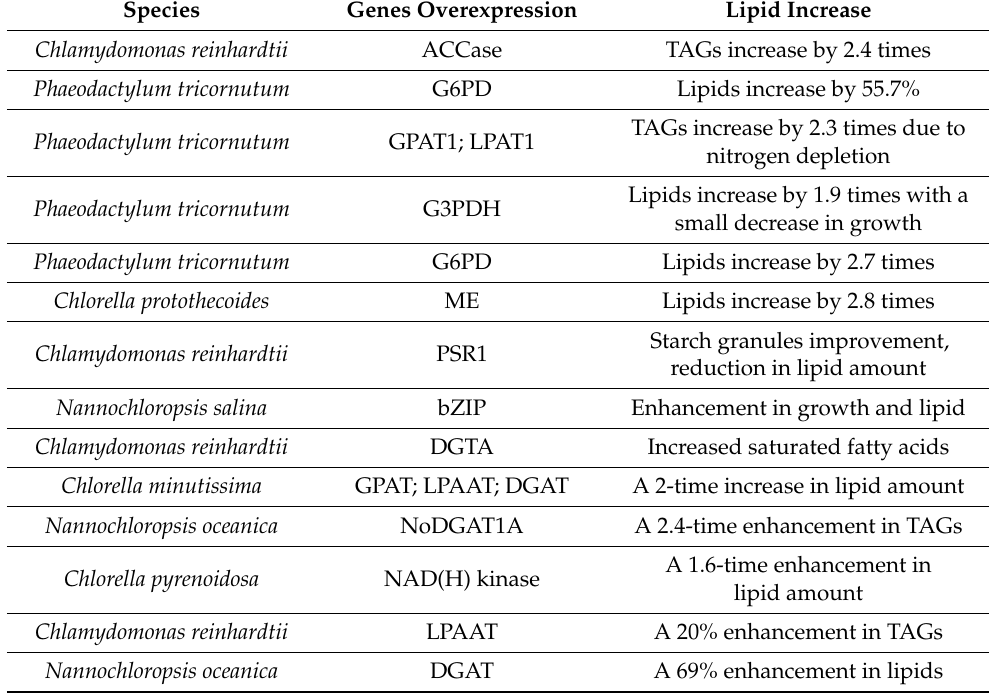
Table 1. Lipid improvement due to gene overexpression in several microalgal species [54]. Species Genes Overexpression Lipid Increase Chlamydomonas reinhardtii ACCase TAGs increase by 2.4 times Phaeodactylum tricornutum G6PD Lipids increase by 55.7% TAGs increase by 2.3 times due to GPAT1; LPAT1 nitrogen depletion Lipids increase by 1.9 times with